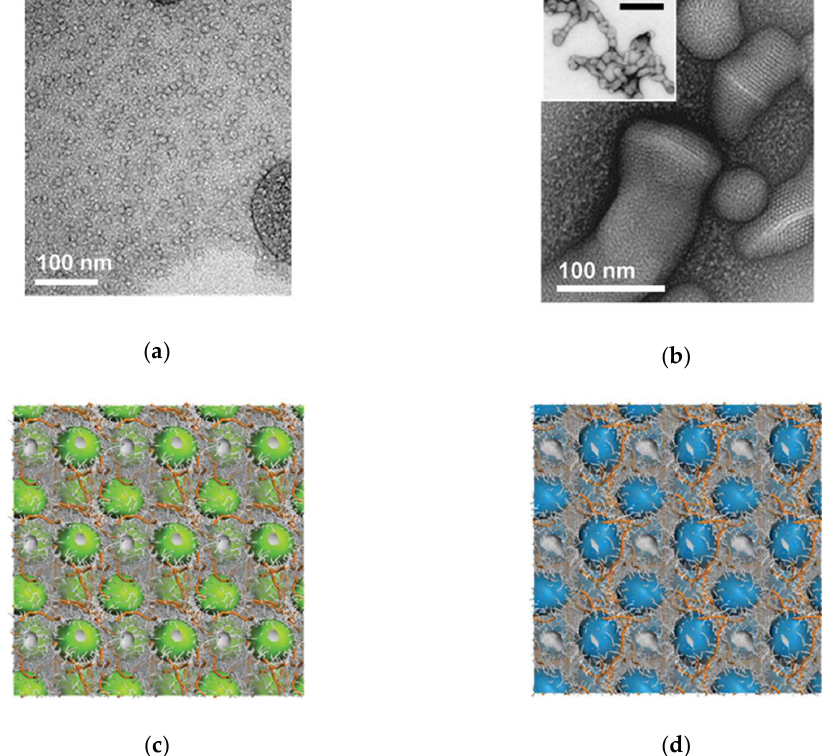
Figure 8. TEM images of C 16 G 0 self-assembled dendrons alone ( a ) and in the presence of heparin ( b ). In panel ( b ), the inset shows the full image indicating the overall nanoscale aggregate. Mesoscale molecular simulations images of C 14 G 0 ( c ) and C 16 G 0 ( d ) self-assembled dendrimers in the presence of heparin (heparin/binder ratio 1:2) in buffered solutions at 150 mM NaCl. The hydrophobic micellar core of is highlighted as green and blue surfaces, respectively, while the hydrophilic parts of each dendron type are shown as white sticks. Heparin chains are portrayed as orange rods, and the solvated environment is visualized as a continuous gray field. Adapted from [24] with the permission of The Royal Society of Chemistry.